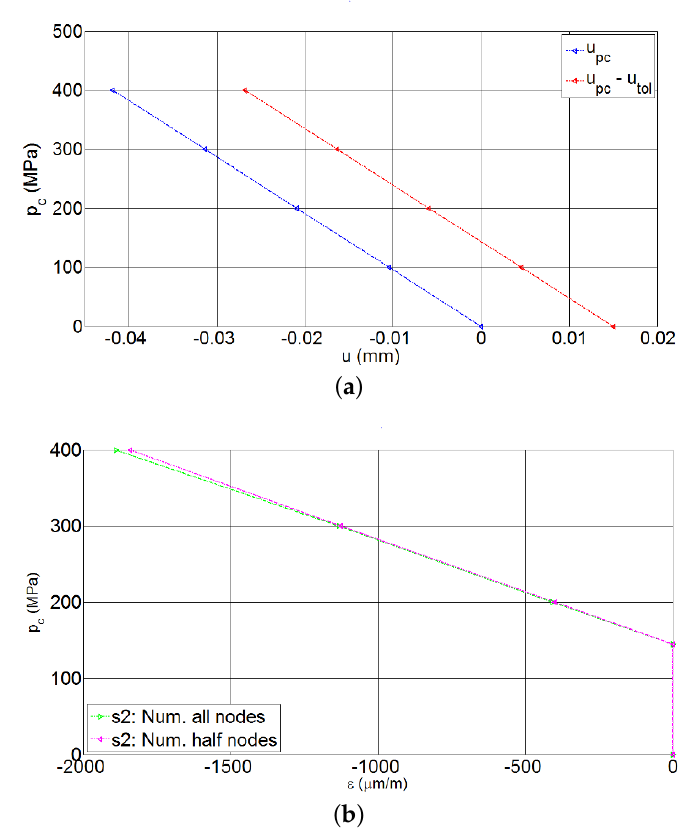
Figure 8. Effect of confining pressure on the cap and sensor: ( a ) water collecting cap displacement for 400 MPa of pressure, applied pressure vs. cap inner displacement with and without counting the tolerance; and ( b ) sensor sensitivity after applying the tolerance, p c vs. (cid:101) < 0 in